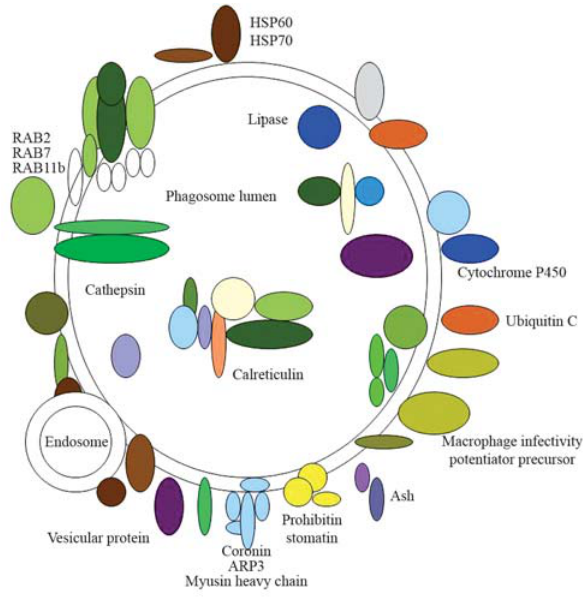
Figure 5 - Schematic illustration of Leishmania spp . proteins that are seemingly homologous (by sequence alignments) to the proteins of the virtual phagosome depicted on the article by Garin et al. , 2001. Selected proteinswereusedinthepresentstudyinanattempttosuggesttheirpoten- tial interaction with phagosomes. Assigned localization to the lumen, the membrane,orthecytoplasmicaspectofthephagosomewasthesameindi- cated by Garin et al.